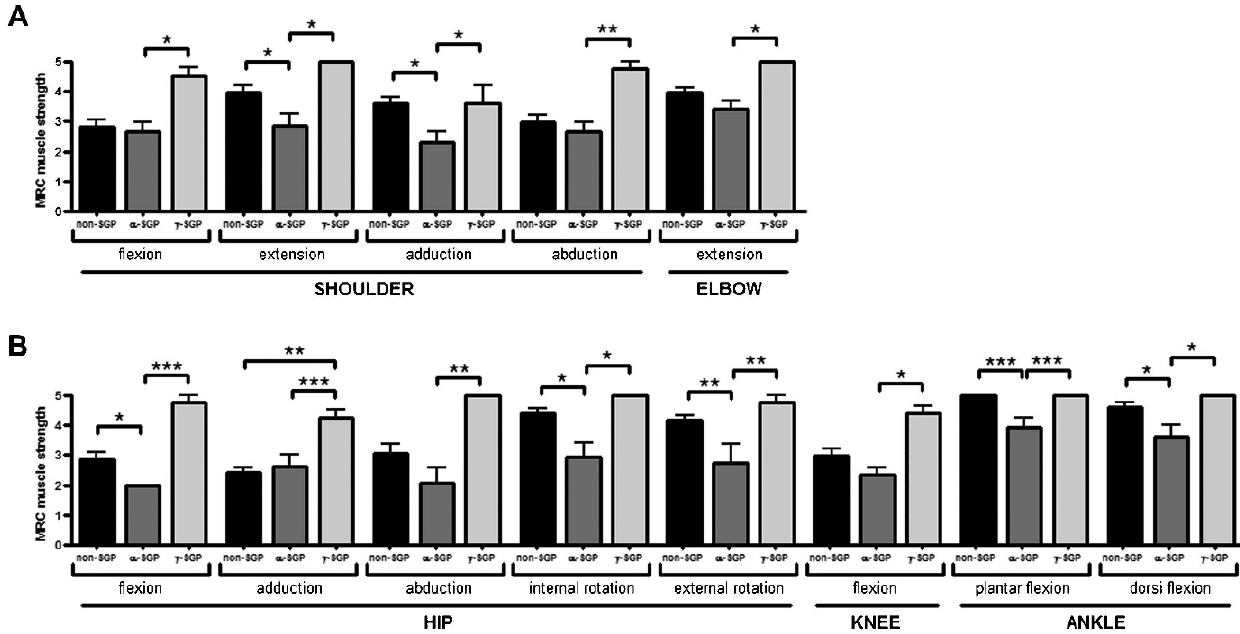
Figure 4 - Graphs illustrating the differences found among the three groups from the comparative analysis of the muscle strength scores of the shoulders and upper limbs (A) and of the hips and lower limbs (B) (* p , 0.05; ** p , 0.01; *** p , 0.001). non-SGP: positive staining for all sarcoglycans; a -SGP: a -sarcoglycanopathy; c -SGP: c